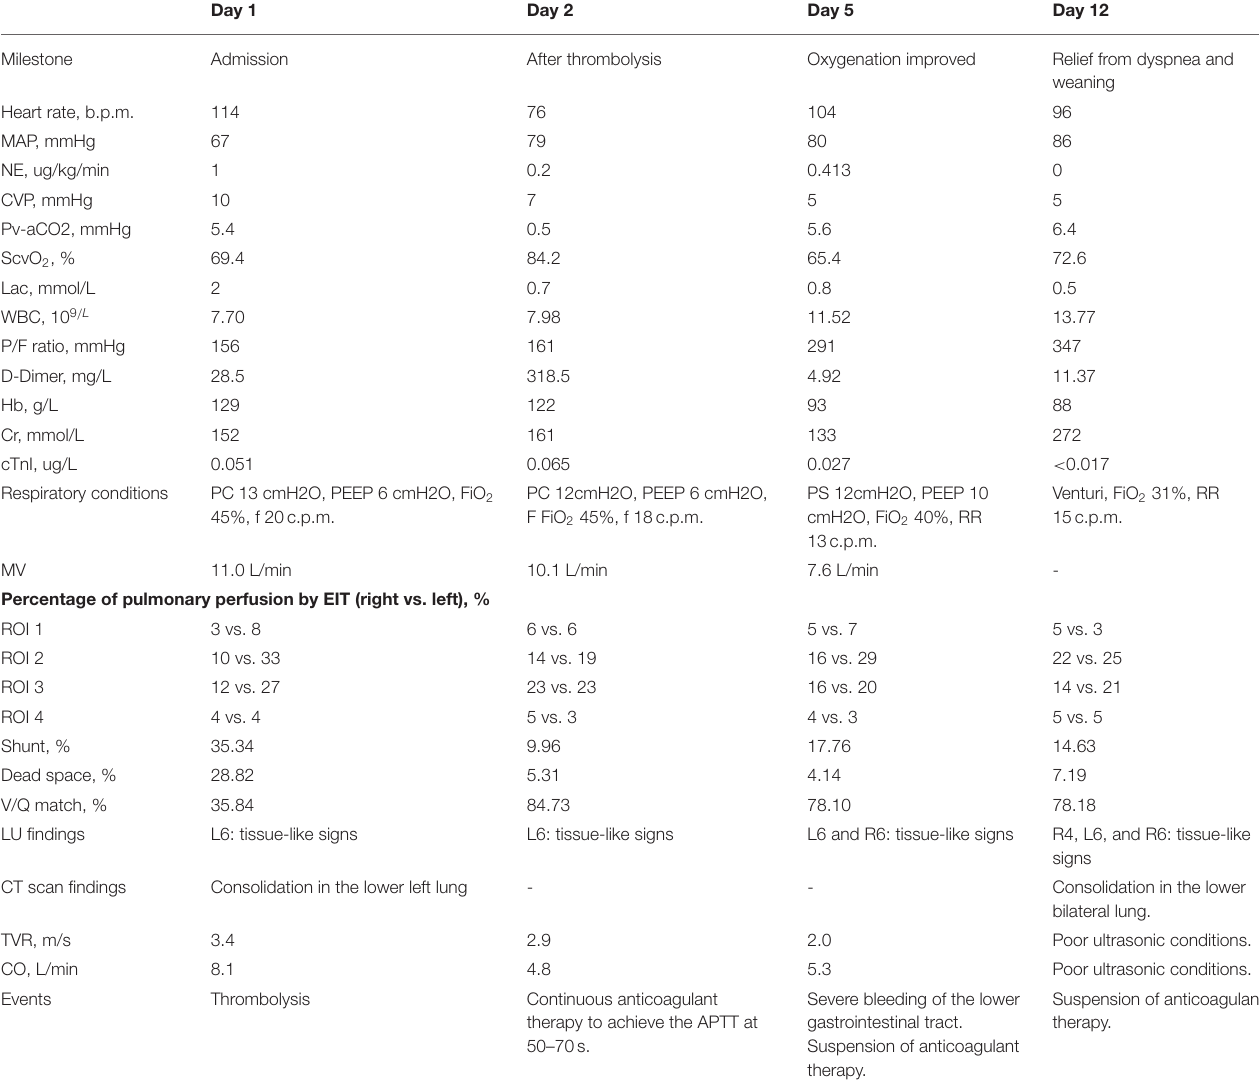
TABLE 1 | Data of PE-related monitoring at different stages of PE recovery. Day 1 Day 2 Day 5 Day